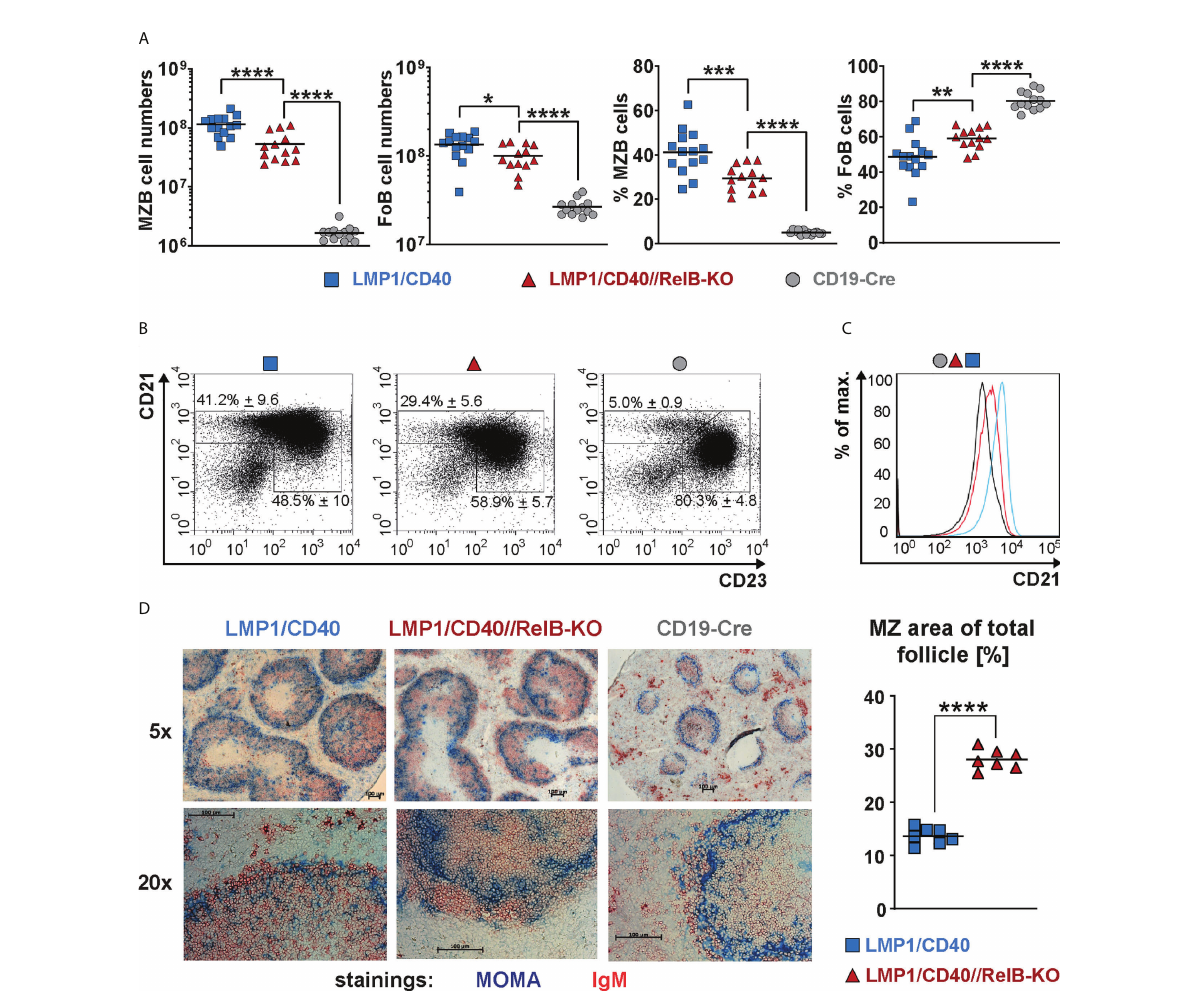
FIGURE 3 CD21 high CD23 low cells are still expanded in RelB-de fi cient LMP1/CD40 mice: (A) Total cell numbers and percentages of FoB and MZB cells in the spleen. N ≥ 13 individual mice per genotype. Ordinary one-way ANOVA with Tukey ’ s multiple comparison was performed with * P<0.05, ** P<0.01, *** P<0.001, **** P<0.0001. Values were logarithmized before statistical analysis. Symbols represent values from individual mice, and the lines indicate the means. (B) Representative FACS plots to differentiate MZB (CD21 high CD23 low ) and FoB (CD21 + CD23 + ) cells. FACS plots are pre-gated on live B220 + lymphocytes. (C) Overlay of the CD21 surface expression of splenic B lymphocytes from mice with the indicated genotypes. (D) Splenic sections from the indicated genotypes were stained with an anti-IgM (red) antibody to detect B cells and an anti-Moma-1 (blue) antibody to visualize metallophilic macrophages lining the Marginal Zone sinus. One representative experiment is shown; N =3 independent experiments. The graph depicts the percentages of the marginal zone area within the total follicle area from the indicated genotypes. Areas were determined in 7 different follicles using ImageJ as described in Materials and Methods. Supplementary Figure 7 shows an example of MZ zone delineation. Unpaired two-tailed t test was performed with ****